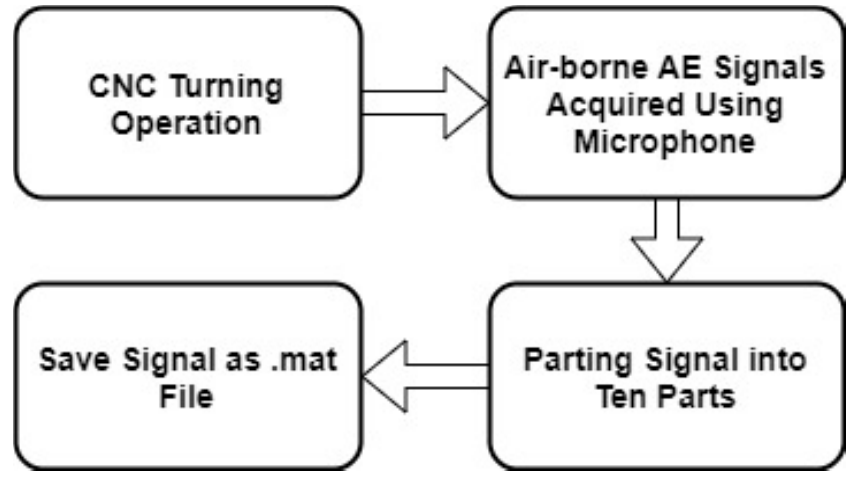
Figure 11. Flow diagram of data acquisition and preprocessing.